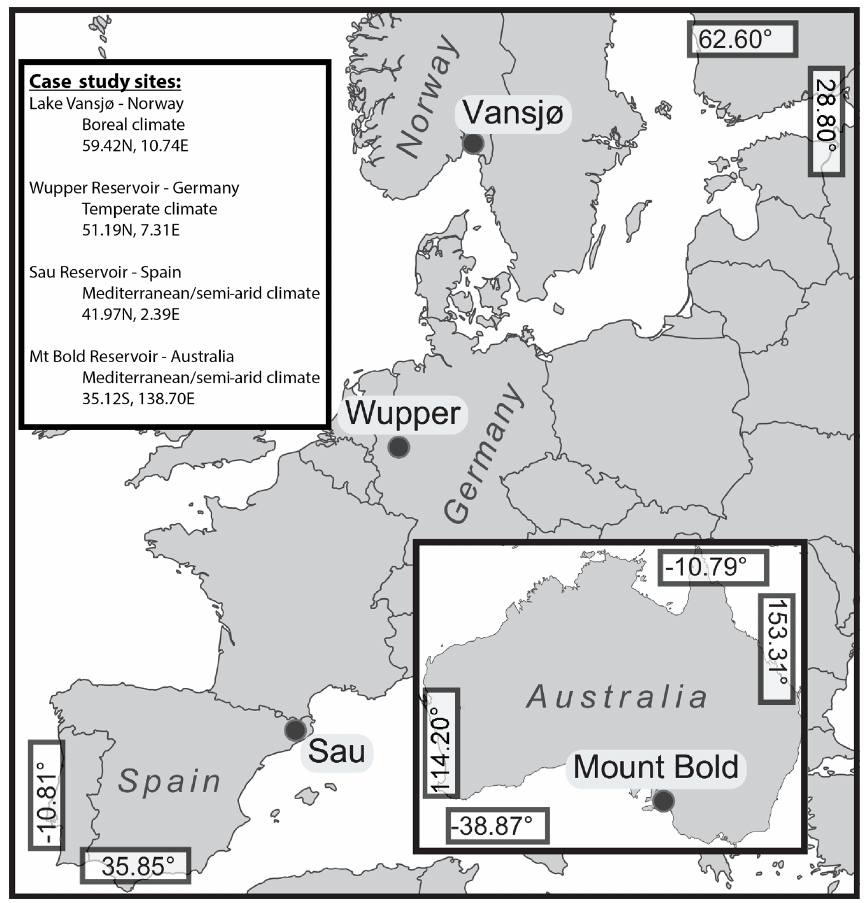
Figure 1. Location of the four case studies in Europe and Australia, along with climate type and coordinates. Map has been modified from Jackson-Blake et al. (2022). Detailed catchment maps are given in Jackson-Blake (2022). Table 1. Characteristics of the study sites. Mixing timing refers to boreal seasons only. Case study